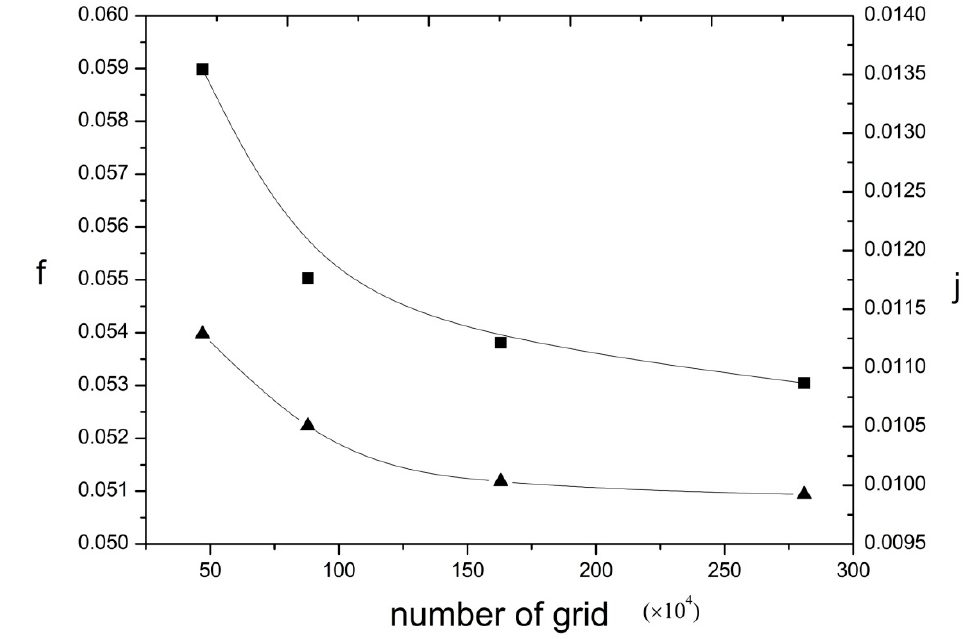
Figure 3. The grid independence with Re = 2000.